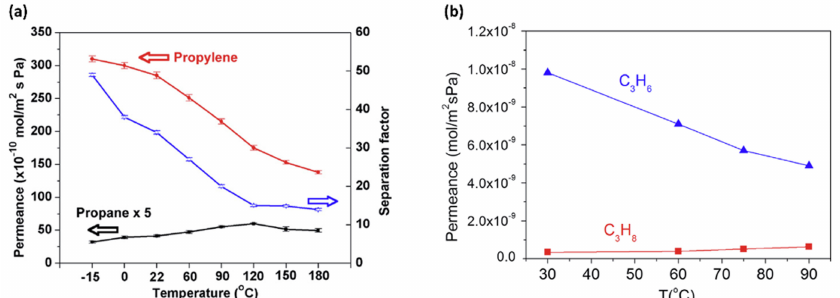
Figure 10. ( a ) Temperature dependence of permeances and propylene/propane mixture separation factor for ZIF-8 membrane [61]. ( b ) Temperature dependence of single gas permeances of propylene and propane for ZIF-8 membrane